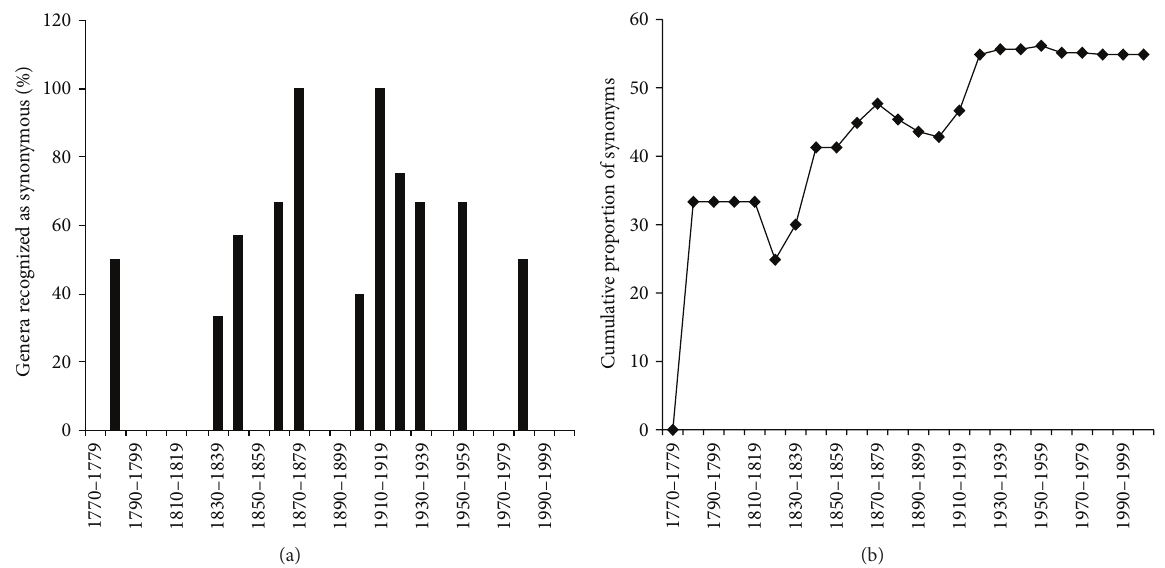
Figure 7: Percentage of synonymous genera described in each decade (a) and their historical process of accumulation